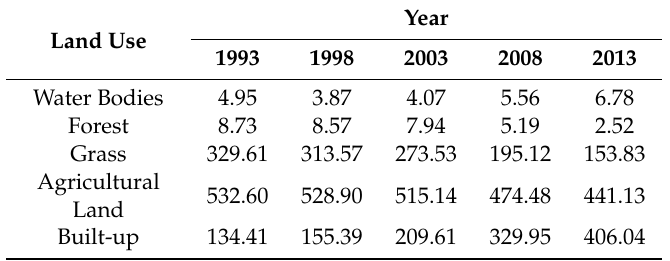
Table 3. Land Use Transfer Matrix of Zhengzhou from 1993 to 2013 (km 2 ).